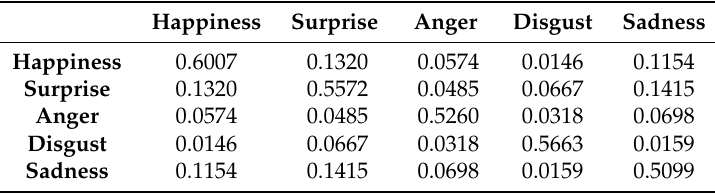
Table 5. Cosine similarity for the 3-CL CNN with single-channel input